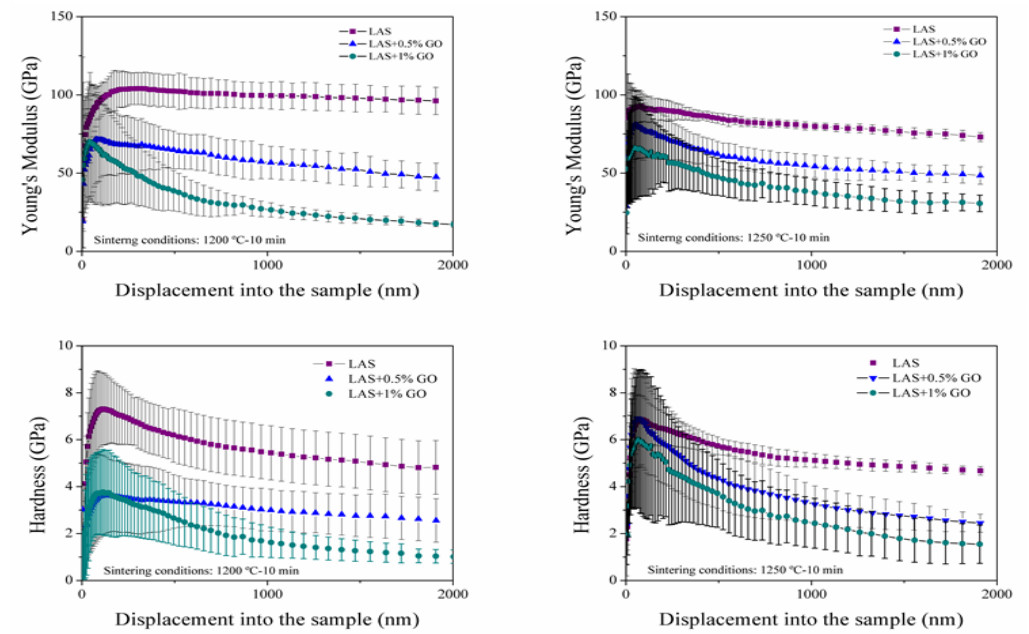
Figure 3. Evolution of the mechanical properties as a function of graphene content and sintering temperature: 1200 °C ( left ) and 1250 °C ( right ).